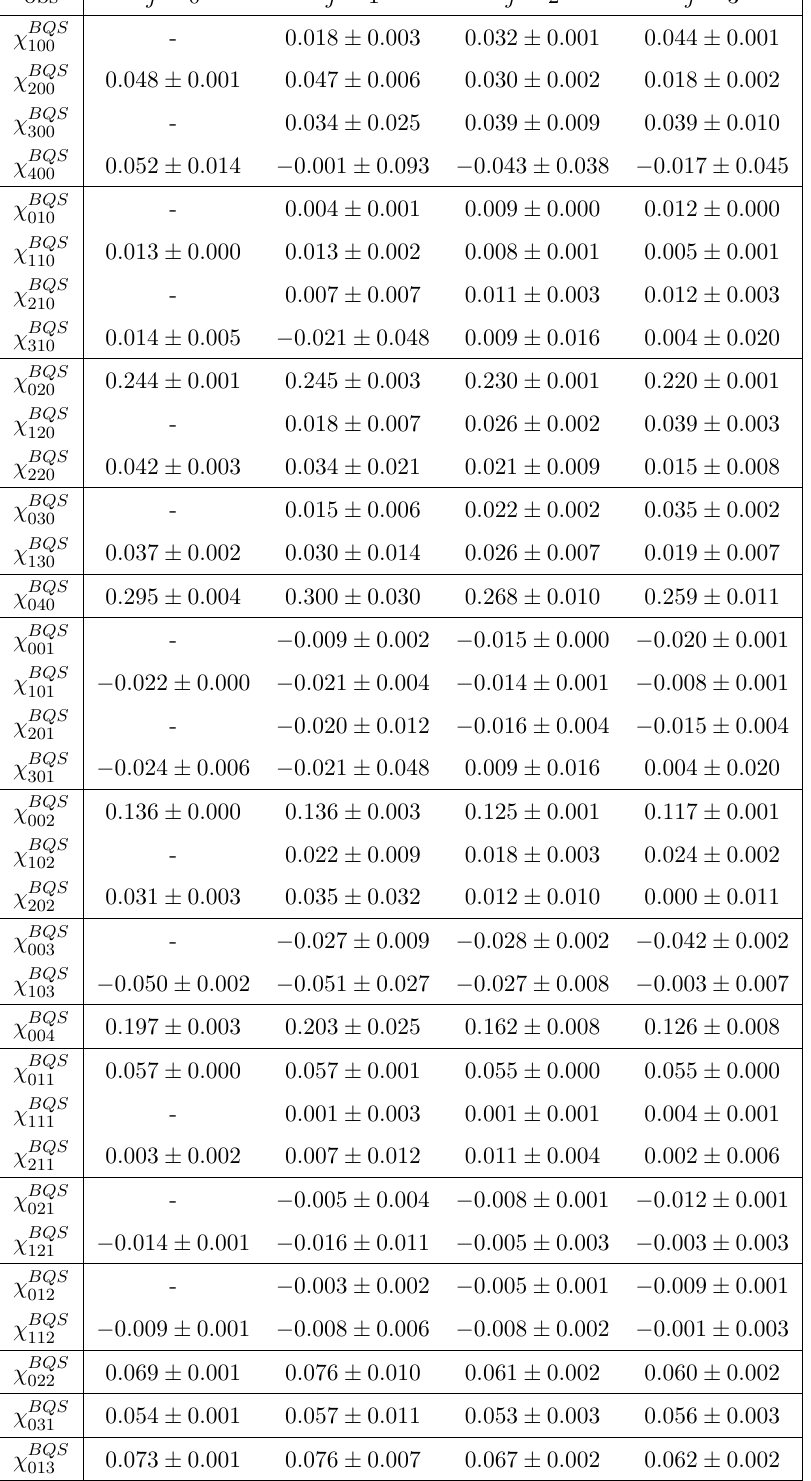
Table 3 . Raw data at T = 140 MeV and (cid:22) ( j )